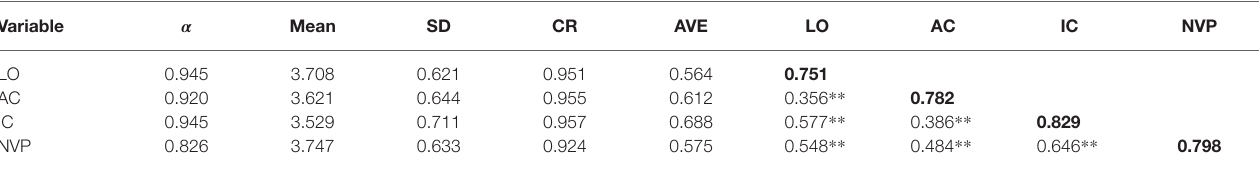
TABLE 3 | Results of the reliability and validity analysis. Variable